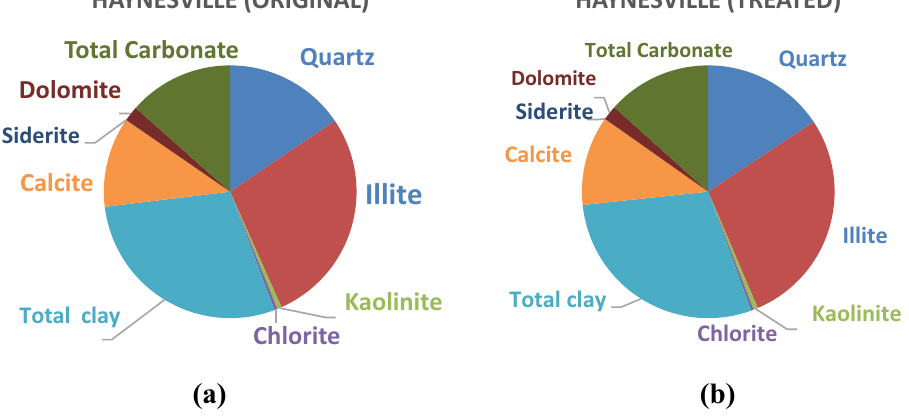
Figure 3. Mineralogy of Haynesville shale. ( a ) Original Haynesville Shale. ( b ) Treated Haynesville Shale.